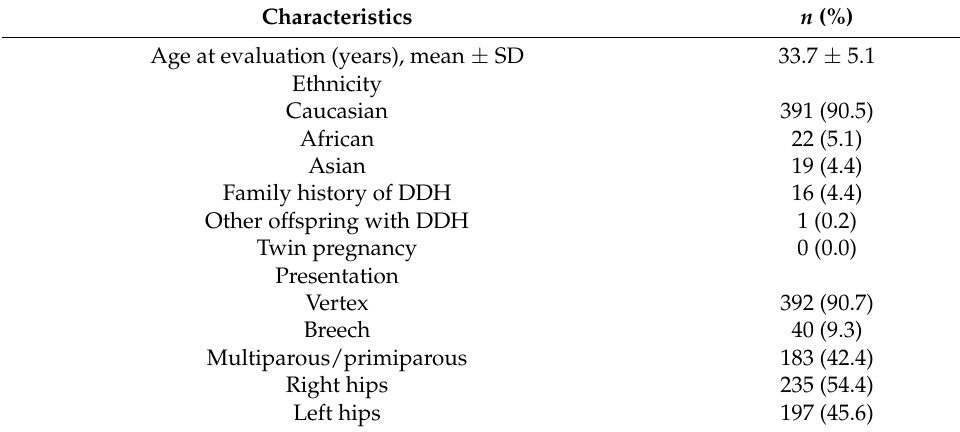
Table 1. Demographic and clinical characteristics of the study sample ( n = 432).